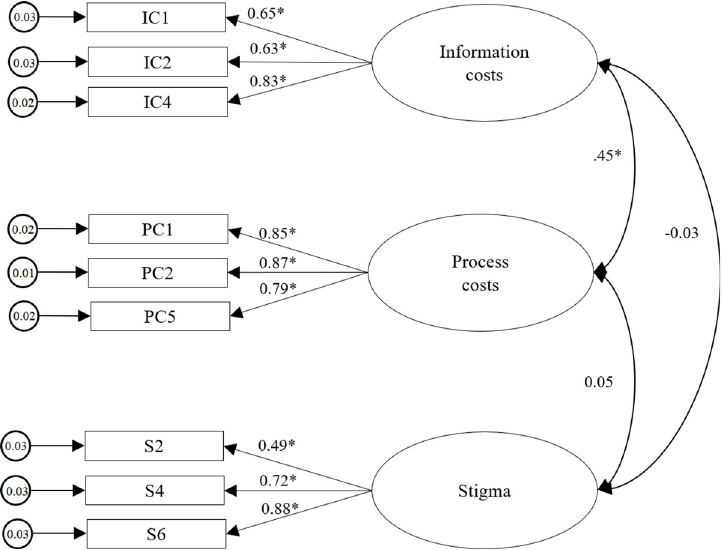
Fig 2. The 3-factor model for the CCS obtained from confirmatory factor analysis (Sample 2, n = 1265). Note. � p < .001.